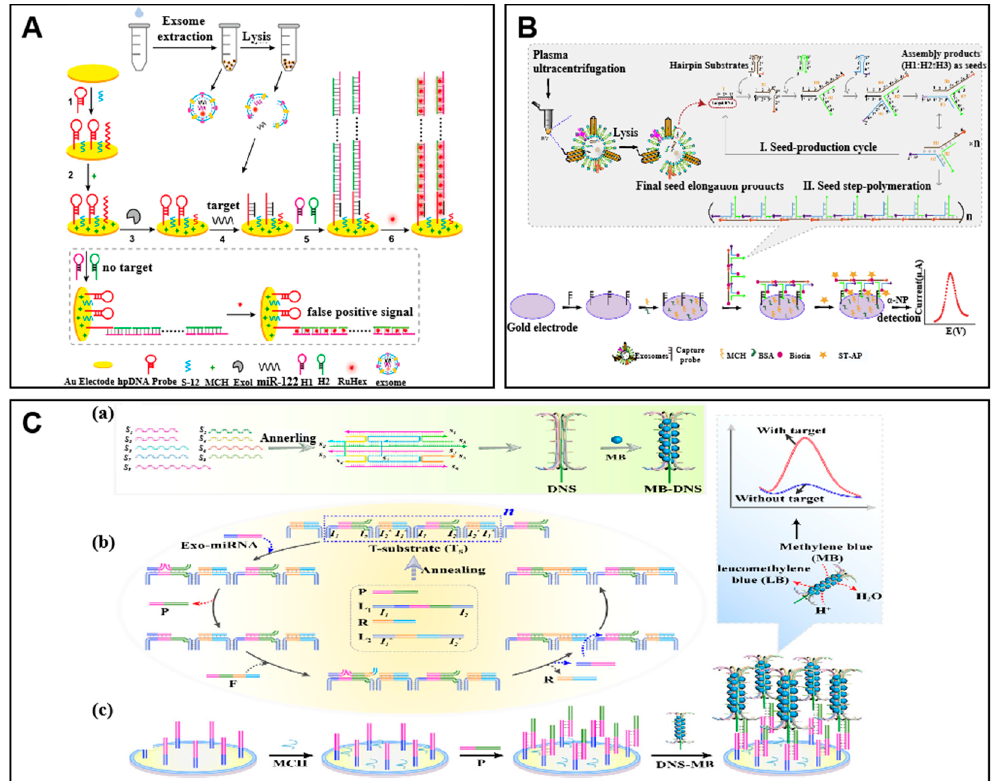
Figure 2. Examples of signal amplification by DNA assembly. ( A ) Schematic of hybridization chain reaction (HCR) based electrochemical biosensor for the detection of exo-miRNA. Adapted with per- mission from [53]. Copyright 2020 American Chemical Society. ( B ) Schematic of the electrochemical biosensor based on a step polymerization catalytic hairpin assembly (SP-CHA) assay. Adapted with permission from [56]. Copyright 2021 Elsevier. ( C ) Schematic of the electrochemical biosensing assay based on localized DNA cascade displacement reaction (L-DCDR). (a) The procedure of MB-DNS assembly. (b) The procedure of L-DCDR. (c) The binding of the MB-DNS on the electrode. Adapted with permission from [59]. Copyright 2020 American Chemical Society.